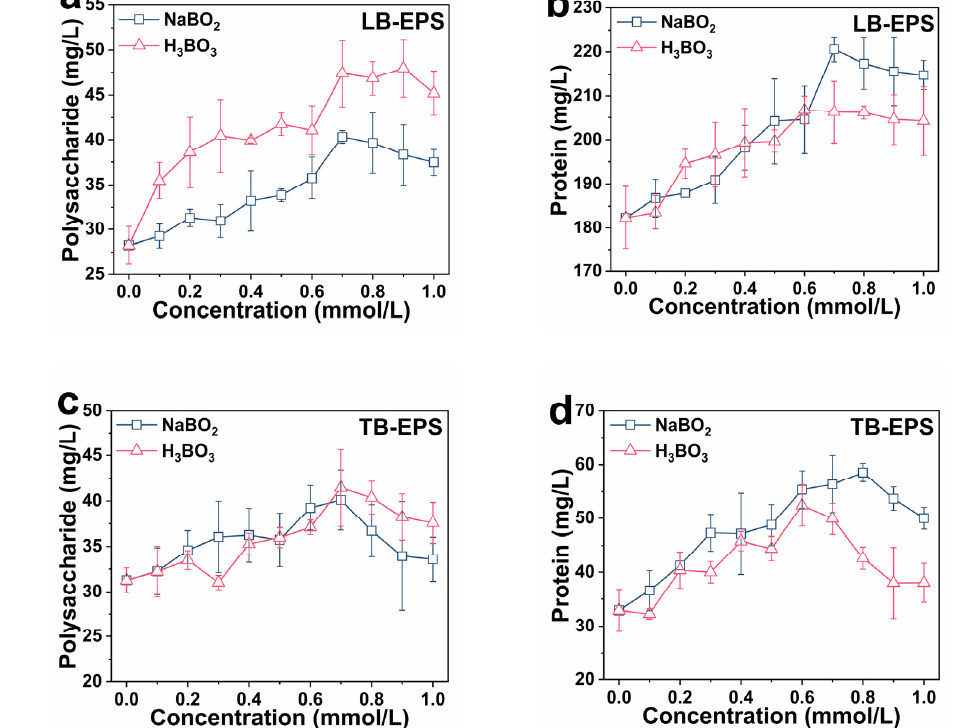
Figure 5. Effects of boron derivatives concentration on LB-EPS-polysaccharide ( a ), LB-EPS-protein ( b ), TB-EPS-polysaccharide ( c ), and TB-EPS-protein ( d ). Extracting conditions: The bacterial liquid was centrifuged and collected. The bacterial sludge was suspended at 70 °C and 0.05% NaCl. Immediately, the mixture was centrifuged and the supernatant was loosely bound EPS (LB-EPS). Sludge deposition in LB-EPS was suspended with 0.05% NaCl. The mixture was placed in a water bath at 70 °C for 30 min, centrifuged and the supernatant was taken as tightly bound EPS (TB-EPS).